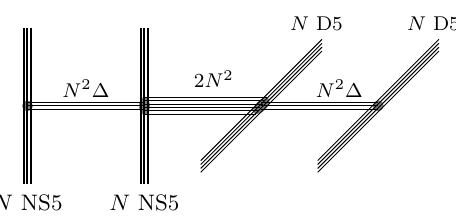
Figure 11. D3-branes suspended between two groups of D5-branes and two groups of NS5-branes. The associated supergravity solutions is given by